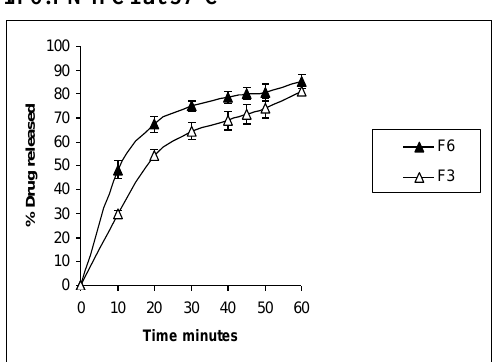
Figure2: Effect of type of diluents on the dissolution of piroxicam in 0.1 N HCl at 37°C